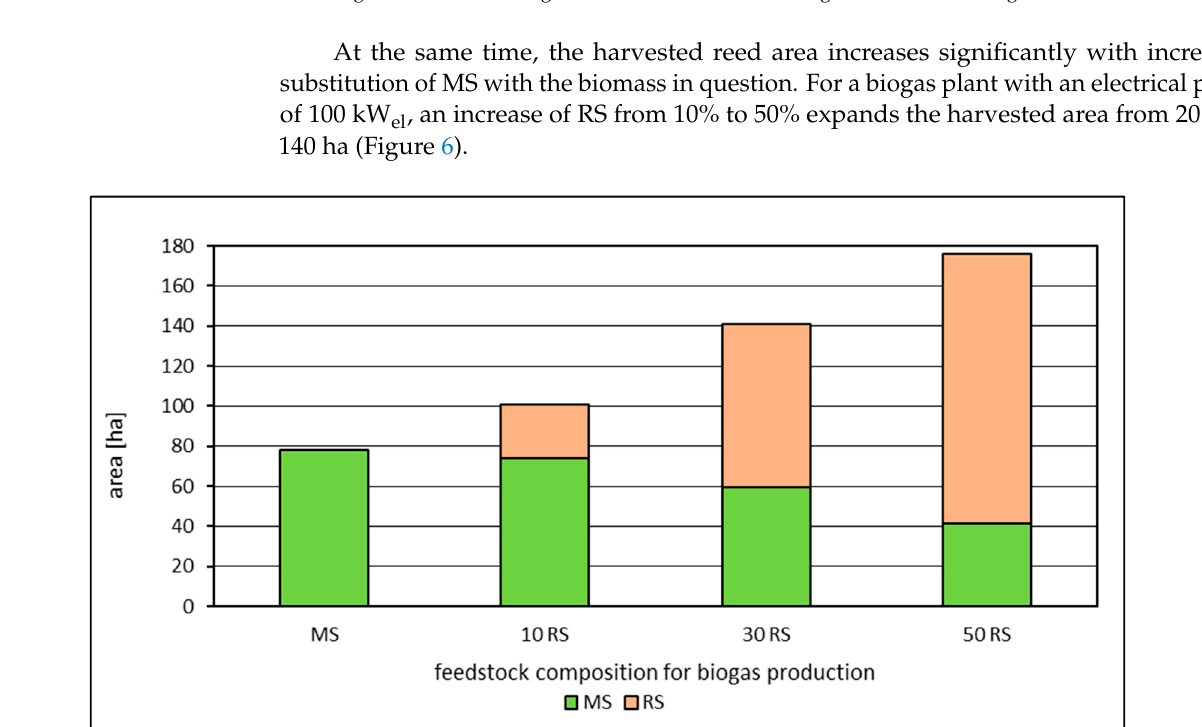
Figure 6. The area required for maize and reed cultivation based on the example of a biogas plant with an installed electrical power of 100 kW el . MS—maize silage, 10 RS—maize silage with 10% content of reed silage, 30 RS—maize silage with 30% content of reed silage, 50 RS—maize silage with 50% content of reed silage.